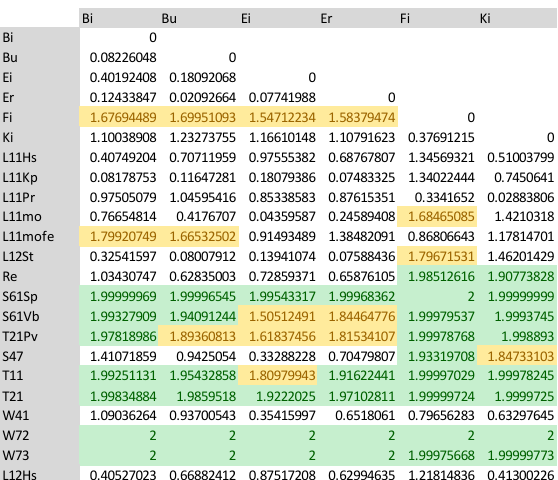
Figure 4. Extract of the red-edge transformed divergence for the tree species classes against all